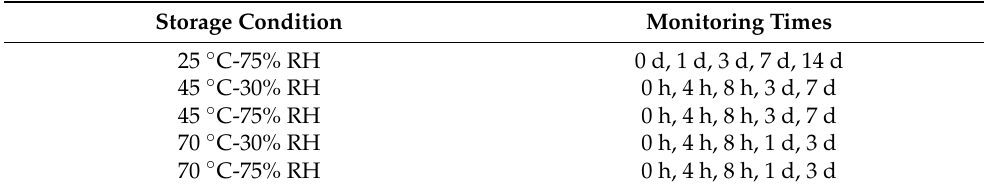
Table 1. Conditions used for forced degradation tests and experimental scheme